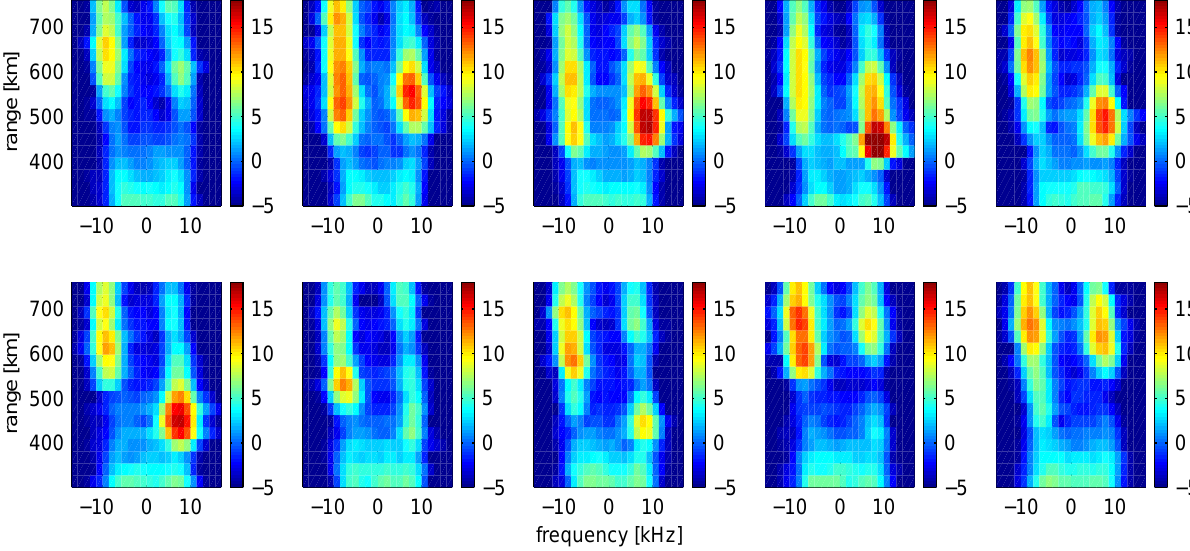
Fig. 12a, plotted versus range and maximum horizontal